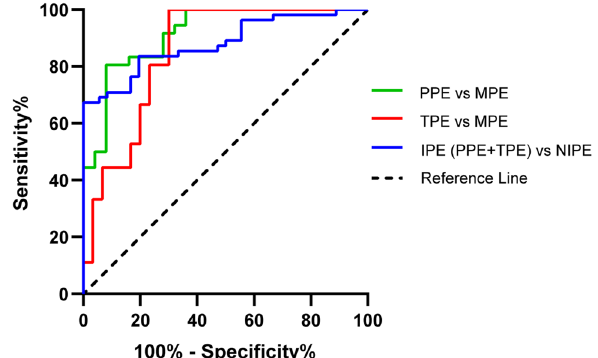
Figure 5. Receiver operating characteristics (ROC) curves of pleural fluid NAMPT for distinguishing infectious pleural effusions. PPE parapneumonic effusion, TPE tuberculous pleural effusion, MPE malignant pleural effusion, IPE infectious pleural effusion, NIPE non-infectious pleural effusion.